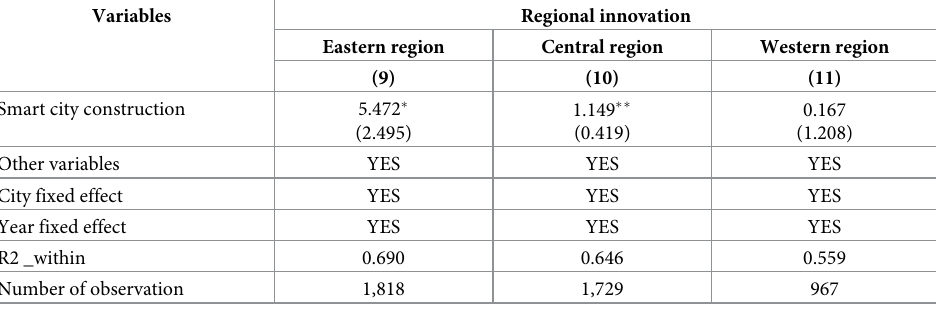
Table 4. The sub-regional regression results of the impact of smart city construction on regional